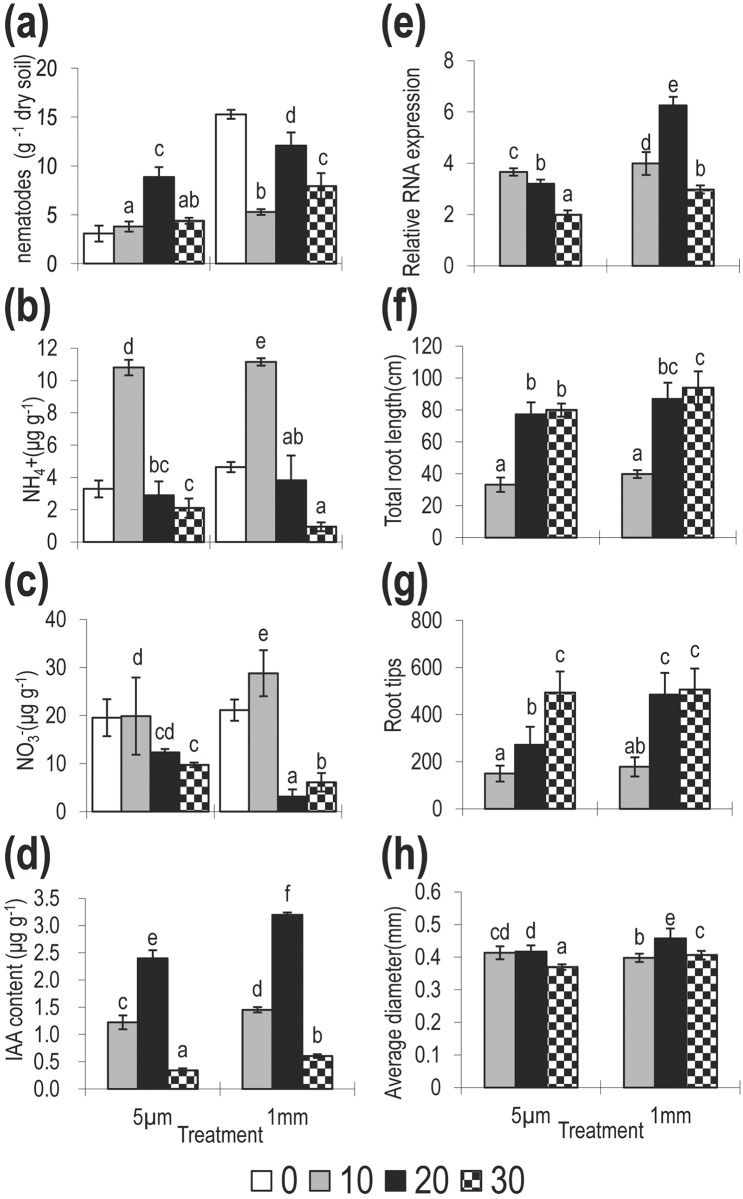
Dynamic of soil parameters, root architecture and relative GH3-2 expression in rice roots in the ‘exclusion’ experiment, after 0, 10, 20 and 30 days of plant growth.Comparisons are shown for two soil types treated using either a 1mm or 5 μm, to allow or exclude (respectively) bacterial-feeding nematodes and where: (a) nematode abundance (b): NH4+, (c) NO3-,(d) IAA content, (e) relative GH3-2 expression: (f) total root length; (g) root tips; (h) root average diameter.